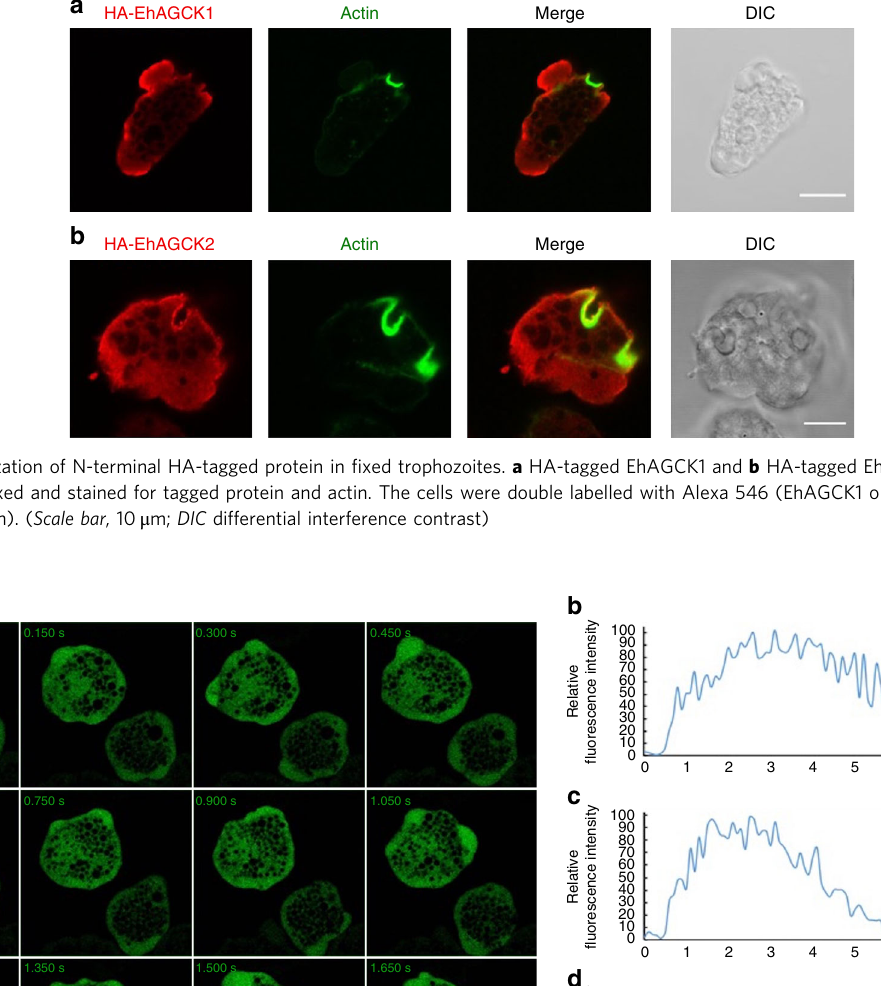
silencing of EhAGCK1 and EhAGCK2.